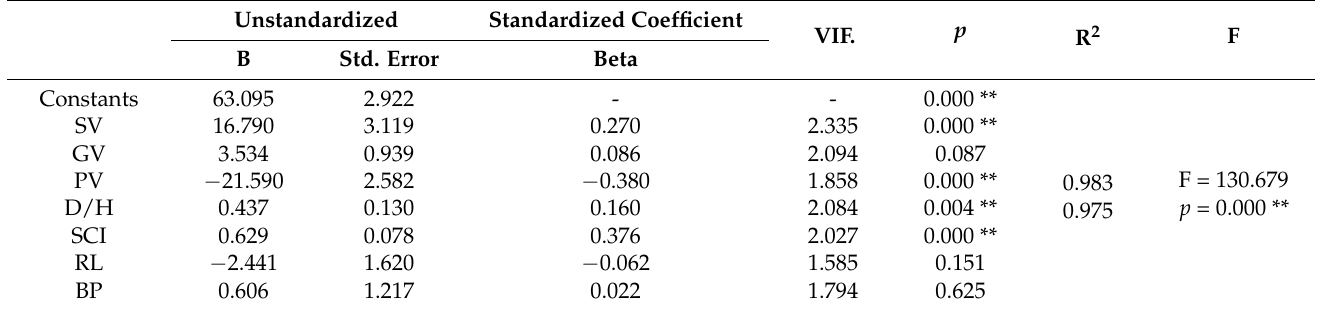
Table 4. Linear regression model of correlation significant spatial features with SDNN.